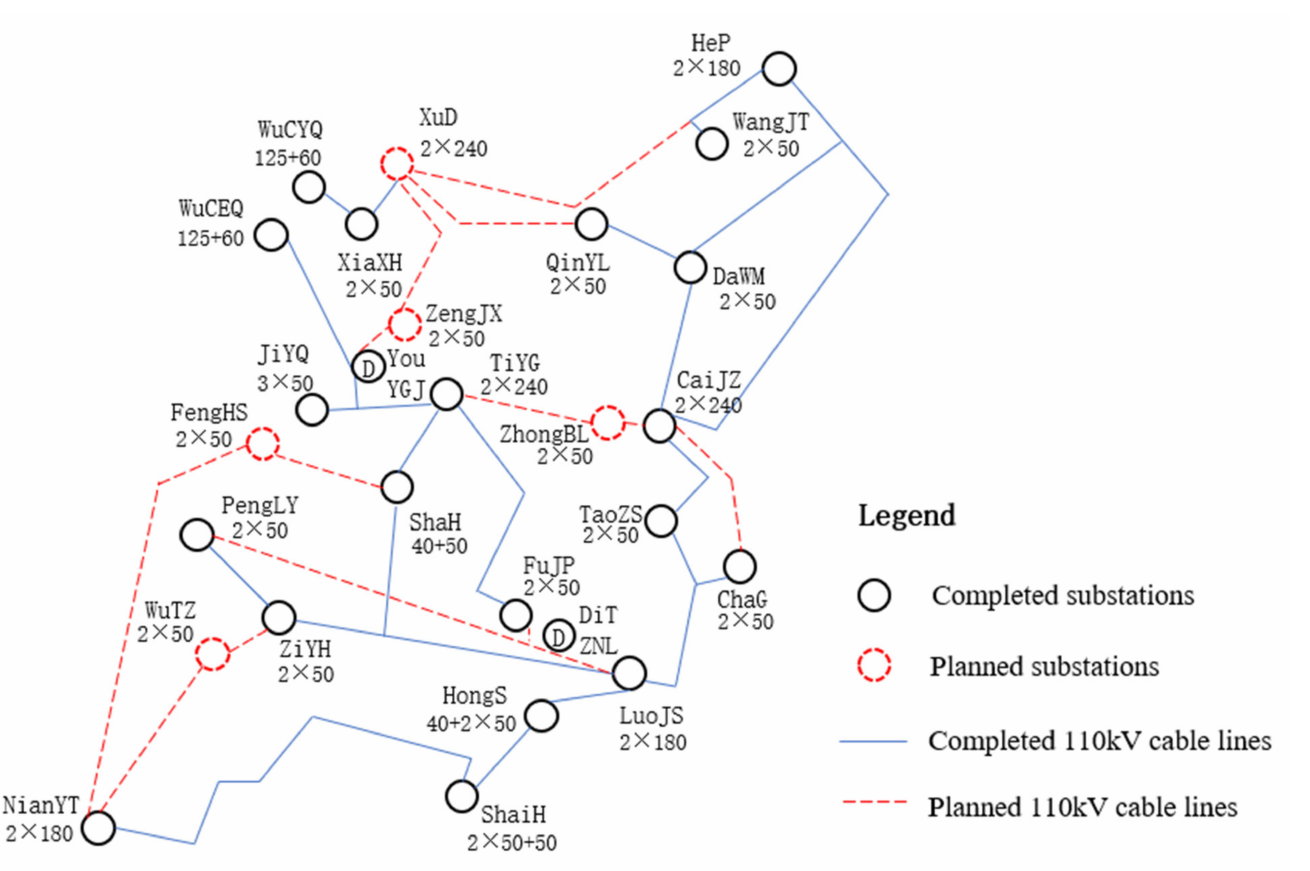
Figure 4. Topological map of power grid in an area of city